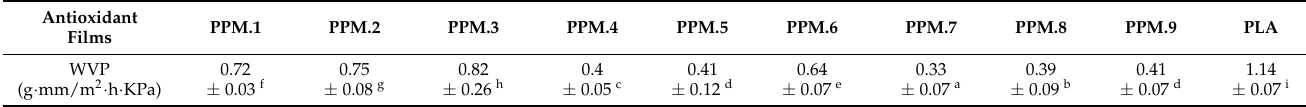
Table 9. The water vapor transmission rate of the antioxidant films of each component ( p < 0.05). Antioxidant